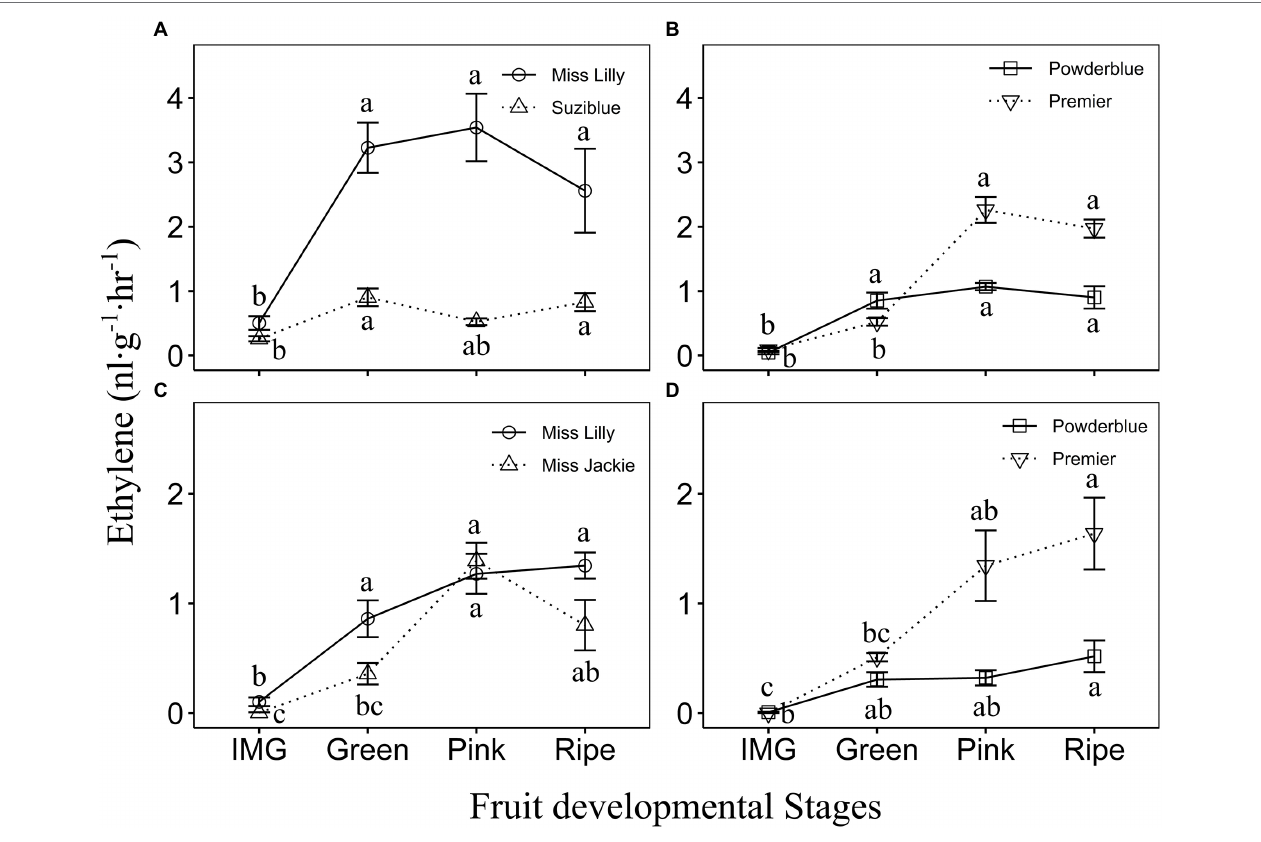
FIGURE 2 | Ethylene evolution in southern highbush (A,C) and rabbiteye (B,D) blueberry cultivars during fruit ripening in 2017 (A,B) and 2018 (C,D) . IMG, Immature Green. The different letters indicate the means are significantly different at different fruit stages within a given cultivar according to ANOVA and Tukey’s HSD ( α = 0.05). Note that the Y -axis scales are different for 2017 (A,B) and 2018 (C,D)